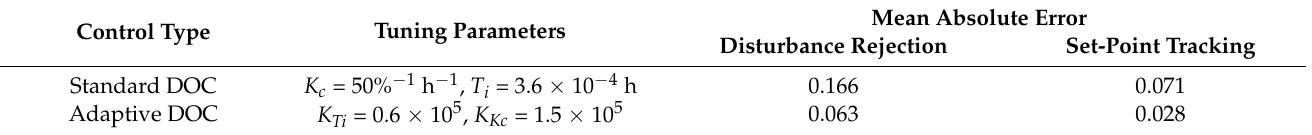
Table 4. Tuning parameters and MAE values for the investigated DOC control systems.